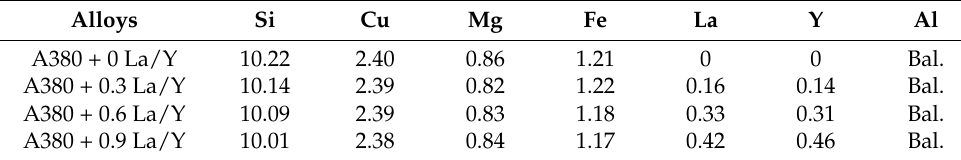
Figure 1. ( a ) mold drawing (unit: mm) and ( b ) tensile specimen bar (unit: mm). Table 2. Chemical compositions of experimental alloys (wt.%).